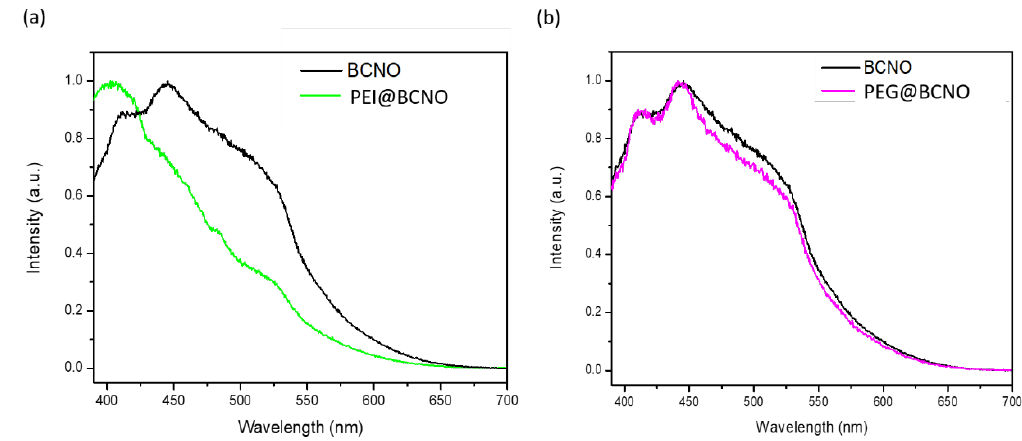
Figure 2. PL spectrum of the bare and functionalized BCNO upon photoexcitation at 365 nm of ( a ) stacked PL spectrum of quasi-spherical BCNO nanoparticles coated with PEI, bare BCNO (black trace), PEI@BCNO (green trace) ( b ) overlay PL spectrum of the bare BCNO (black trace) and PEG@BCNO (pink trace).